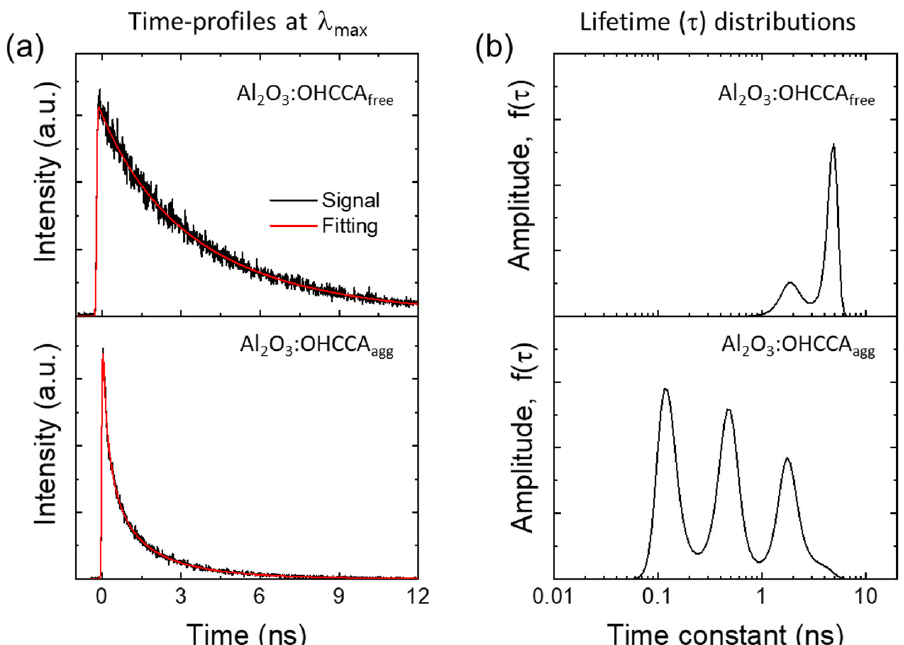
Figure 5. Analysis of time-resolved fluorescence (TRF) of Al 2 O 3 :OHCCA free (top) and Figure 5. Al 2 O 3 :OHCCA agg (bottom): ( a ) Time-profiles of TRF at 460 nm with fits (red lines) and ( b ) Lifetime distributions obtained by the maximum entropy method.